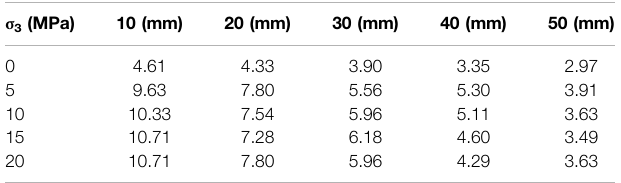
TABLE 4 | Peak Stress (MPa) of the RCR composites at different inclined coal seam thicknesses and different con fi ning pressures.